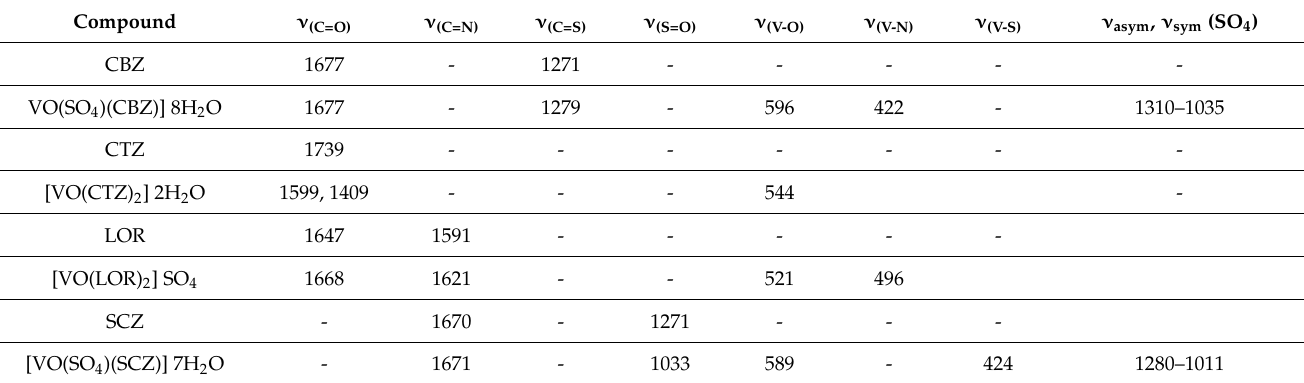
Table 2. The main bands in IR spectra in the range 4000–500 cm − 1 for ligands and their oxidovana- dium(IV)